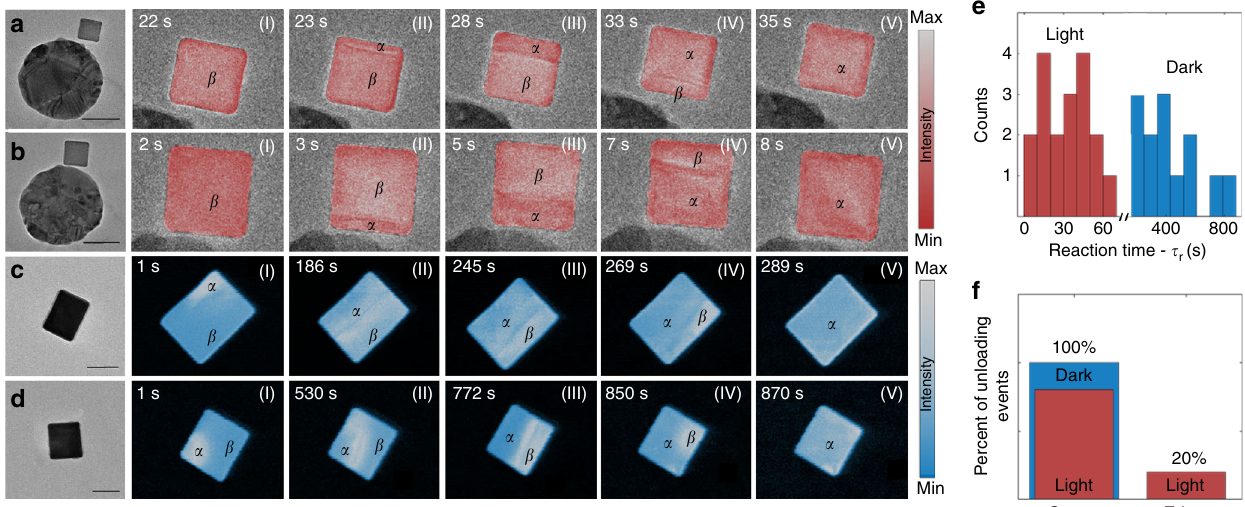
Fig. 3 Comparison between dark and light-induced phase transformation reaction. a – d Snapshots of (scanning) transmission electron microscope movies of the phase transformation reaction in the antenna-reactor (isolated) con fi guration with(out) illumination at 690 nm. Scale bars are 50 nm. e Histograms showing the distribution of reaction times for the plasmon-induced phase transformation (red) and the spontaneous phase transformation (blue) as measured in STEM mode. f Corner vs. edge unloading mechanism with and without illumination, also measured in STEM mode